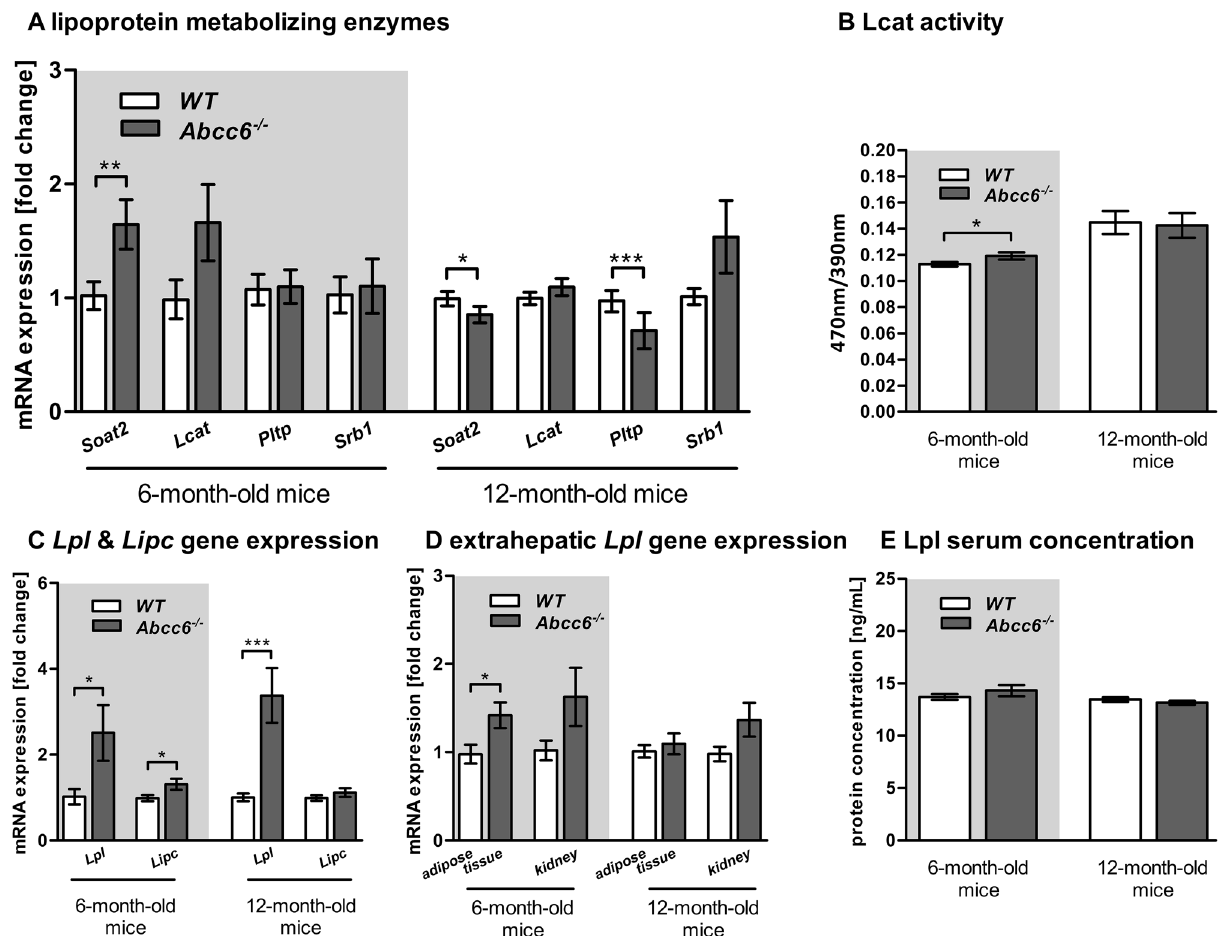
Figure 5. Expression alteration of lipoprotein metabolizing enzymes in Abcc6 knockout mice. ( A ) Relative hepatic gene expression levels of lipoprotein metabolizing proteins (sterol O -acyltransferase ( Soat2 ), Lcat , phospholipid transfer protein ( Pltp ) and scavenger receptor B1 ( Srb1 )) of WT and Abcc6 −/− mice (6-month- old: WT n = 22, Abcc6 −/− n = 25; 12-month-old: WT n = 37, Abcc6 −/− n = 39). Data are fold change of mean ± SD relative to samples of WT. ( B ) The lecithin-cholesterol acyltransferase (Lcat) activity was determined in serum of WT and Abcc6 −/− mice (6-month-old: WT: n = 22, Abcc6 −/− : n = 15; 12-month-old: WT: n = 30 Abcc6 −/− : n = 34). Data are mean ± SD. ( C ) Relative hepatic gene expression level of lipoprotein lipase ( Lpl ) and hepatic lipase ( Lipc ) of WT and Abcc6 −/− mice (6-month-old: WT n = 22, Abcc6 −/− n = 25; 12-month-old: WT n = 37, Abcc6 −/− n = 39). Data are fold change of mean ± SD relative to samples of WT. ( D ) Relative gene expression level of Lpl in the kidney and white adipose tissue of WT and Abcc6 −/− mice (6-month-old: WT: adipose tissue n = 22, kidney n = 25, Abcc6 −/− : adipose tissue n = 18, kidney n = 23; 12-month-old: WT: adipose tissue n = 33, kidney n = 34, Abcc6 −/− : adipose tissue n = 38, kidney n = 42). Data are fold change of mean ± SD relative to samples of WT. ( E ) Quantification of Lpl concentration in serum of WT and Abcc6 −/− mice (6-month-old: WT: n = 23, Abcc6 −/− : n = 21; 12-month-old: WT: n = 33 Abcc6 −/− : n = 29). Data are mean ± SD; Student’s t test; *p ≤ 0.05; ***p ≤